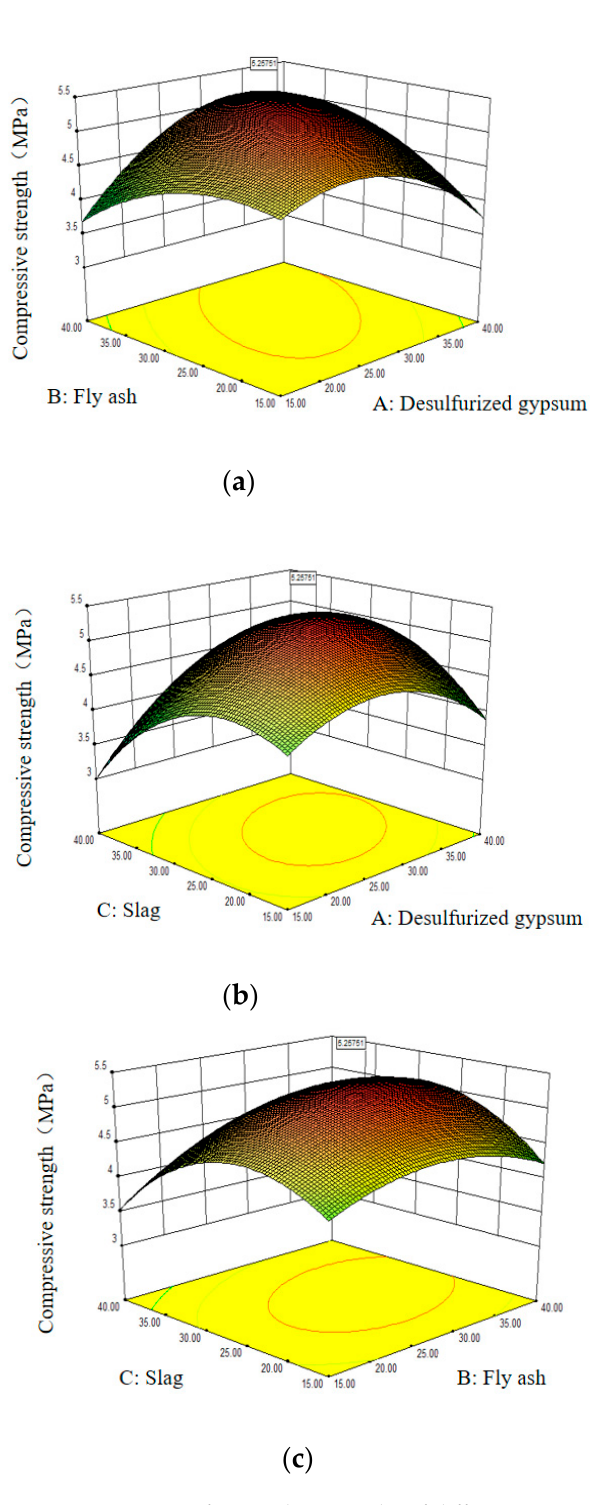
Figure 3. Compressive strength of solidified sludge samples with different additives. Figure 4 shows the uniaxial compressive strengths of the solidified sludge exposed to air and immersed in water. As shown, the compressive strength of MS16–MS18 samples exhibited a complex trend by first slowly increasing and then rapidly decreasing with the prolongation of exposure time in the air, whereas it first decreased rapidly and then slowly increased with the prolongation of water immersion time. After the exposure to air or immersion in water for 30 d, the compressive strength of the samples increased from 10.05 ‒ 15.23 MPa to 10.34 ‒ 16.31 MPa or decreased to 2.67–6.79 MPa. After being exposed to air or immersed in water for 30 ‒ 270 d, the compressive strength consistently decreased to 0.93 ‒ 3.32 MPa or increased to 7.13 ‒ 11.67 MPa, respectively. The maximum compressive strength was observed for the MS16 specimen. The solidified sludge was exposed to air for a long time to cause water loss, which resulted in structural damage and loosened the contact of the particles, ultimately weakening the strength. When soaked in water, indus ‐ trial calcium ‐ containing solid waste can generally continue to undergo hydration reac ‐ tions, thus facilitating the construction of the skeletal structure and promoting increased strength. These findings suggest that solidified sludge is potentially efficient for landfill liner barriers and can maintain a high load ‐ bearing capacity when immersed in water.